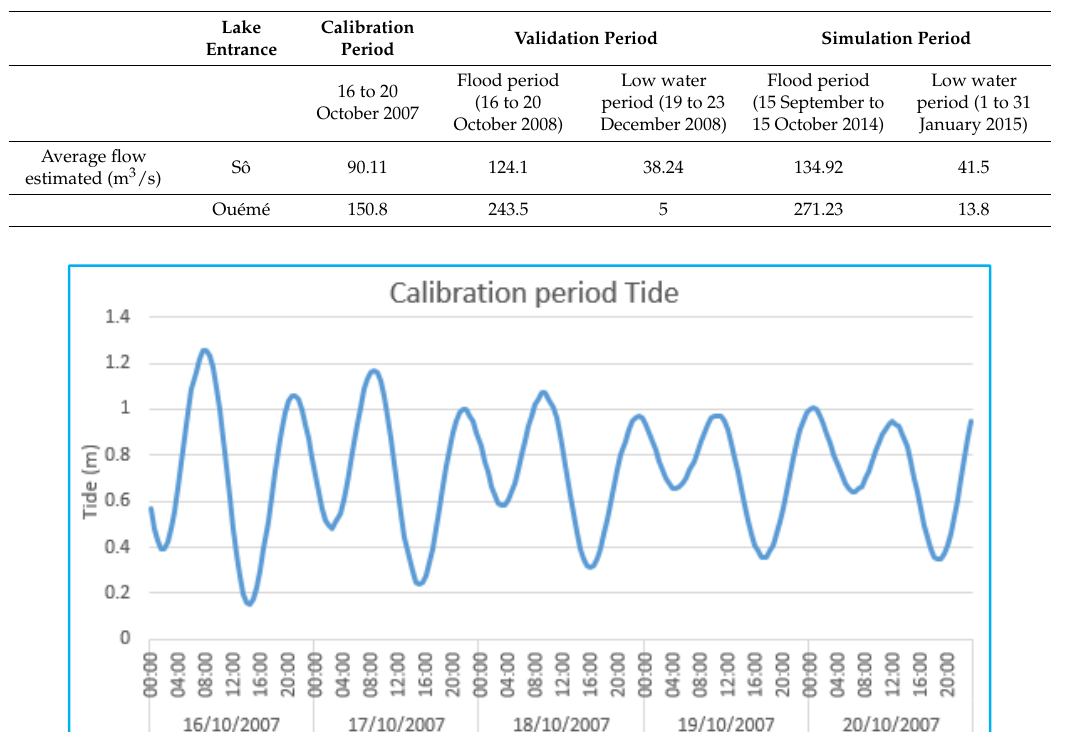
Figure 3. Variation of the tide during calibration period.